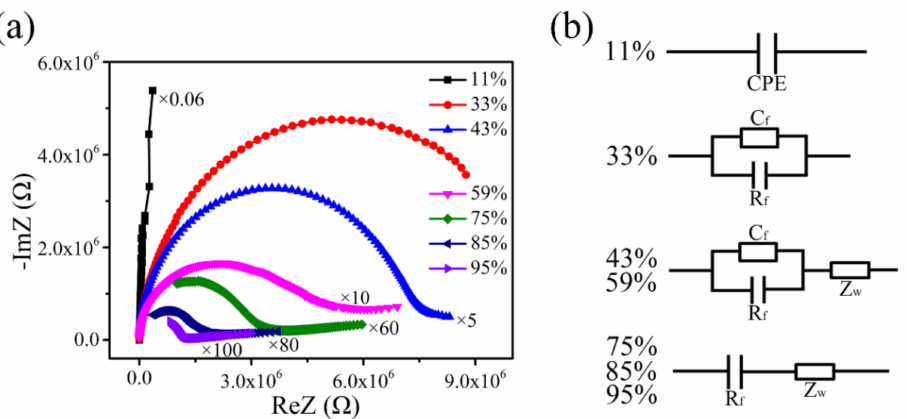
Figure 12. ( a ) Complex impedance spectra and ( b ) equivalent circuit of the Z/S-2 humidity